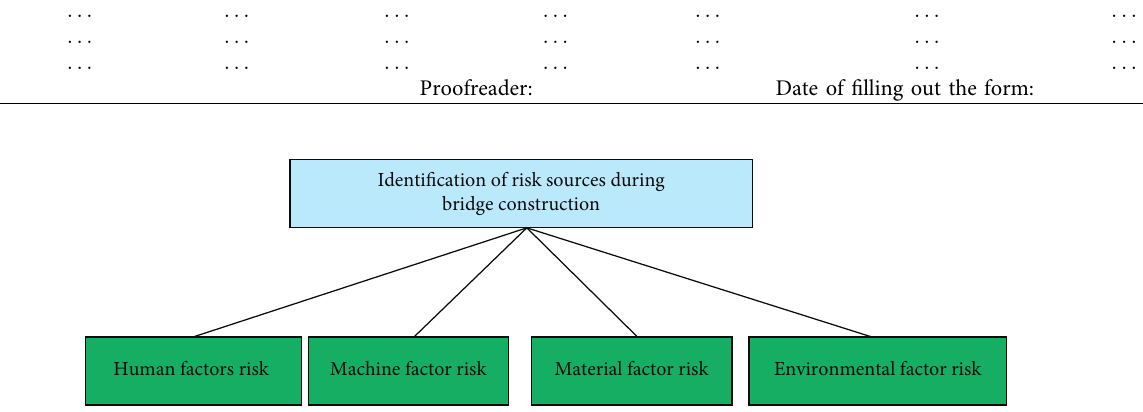
Figure 3: WBS decomposition of risk sources during bridge construction. Table 3: Construction risk factor